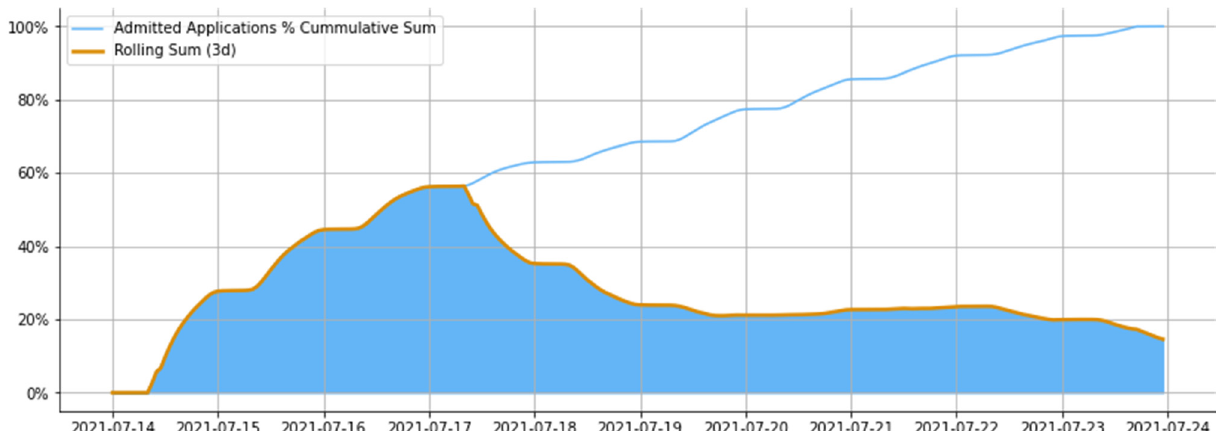
Figure 8. Final score box plot by admission priority.